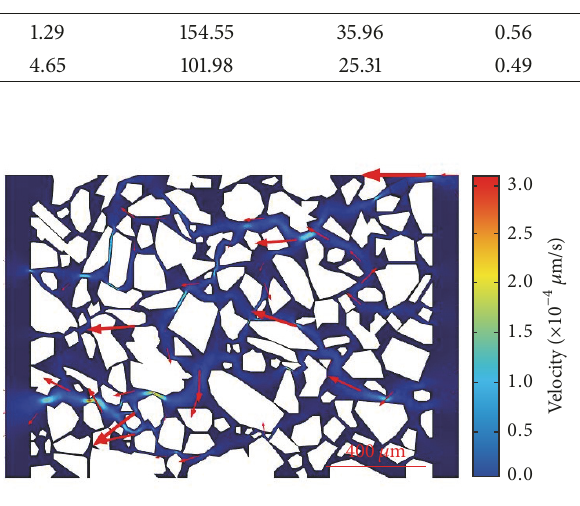
Figure5:SimulationresultsofporevelocityfieldofSample1( 𝜇 m/s).